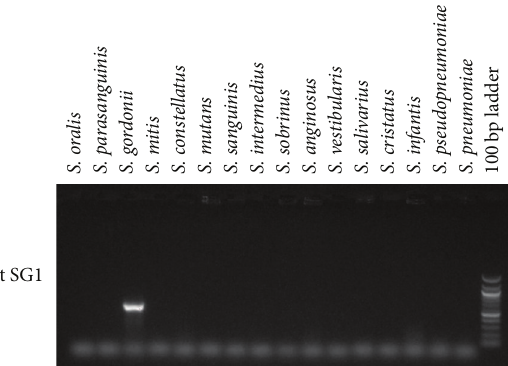
Figure 3: Primer set SG1 was evaluated for specificity by testing for amplification of a PCR product from DNA isolated from a panel of ATCC type strains representing species typically found in the oral cavity. A representative gel is shown.